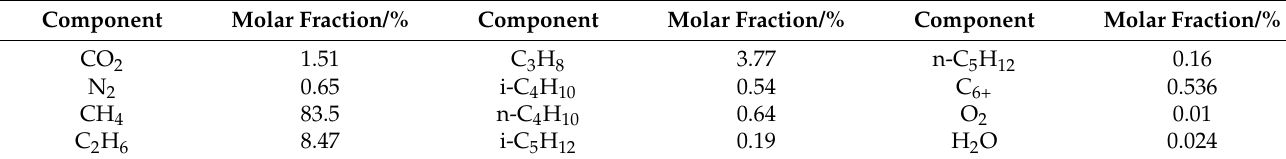
Table 1. Transport medium